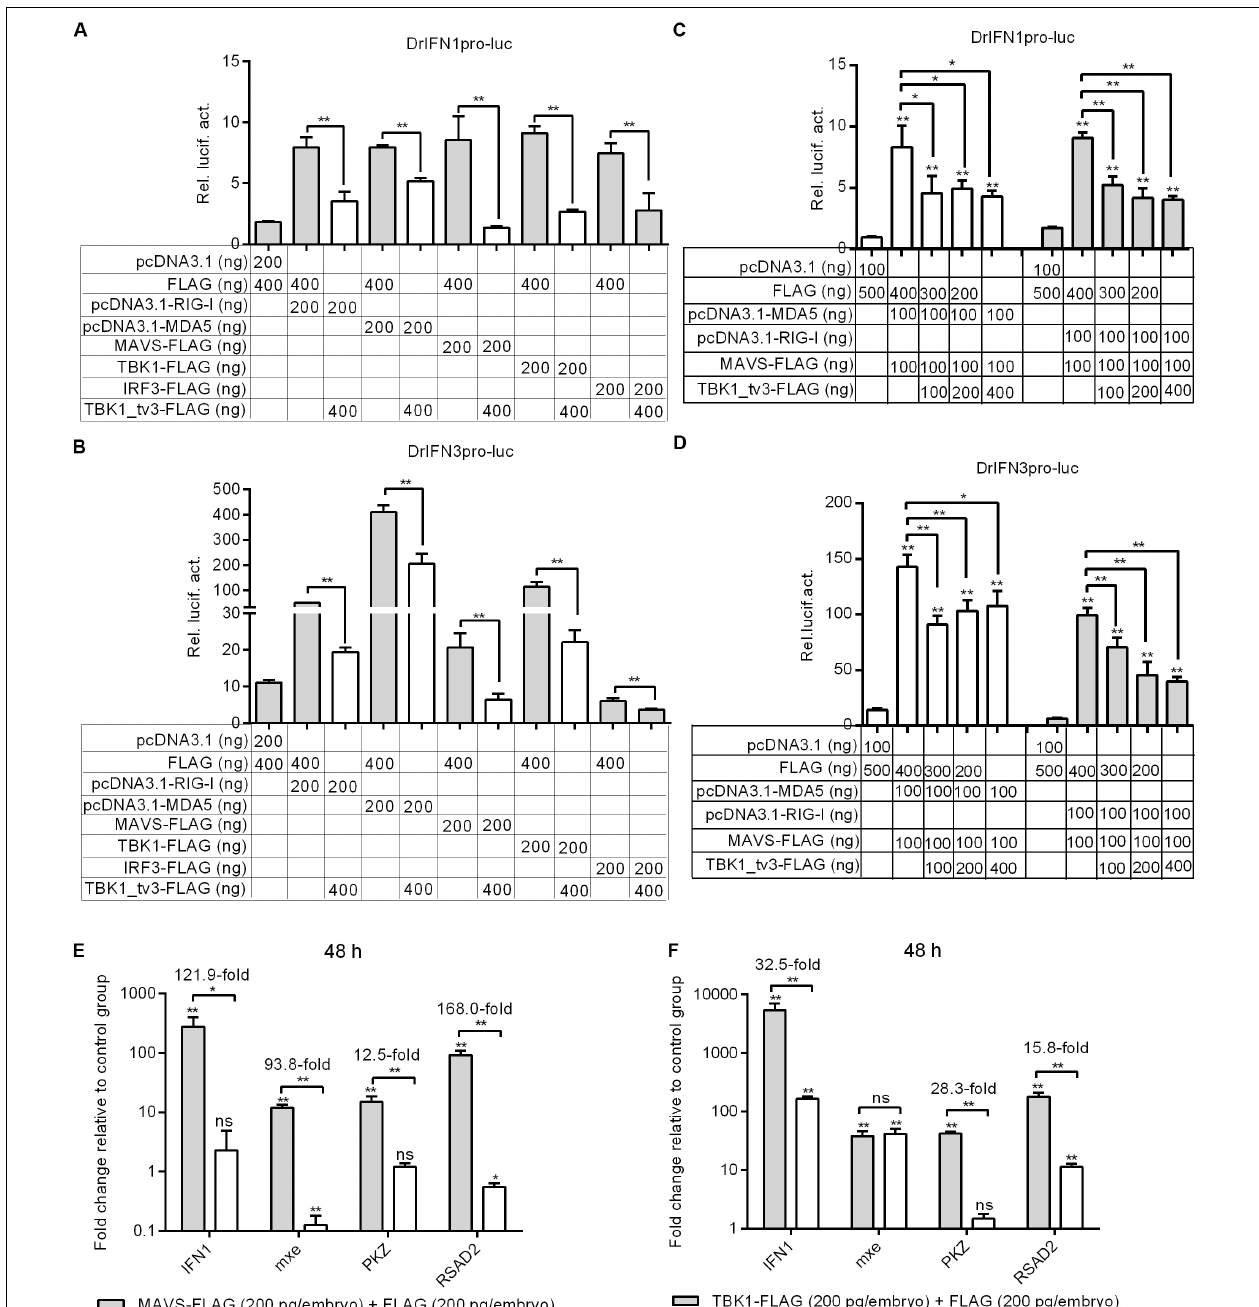
FIGURE 3 | TBK1_tv3 negatively regulates type I IFN mediated by RLR signaling pathway. (A) Effect of zebrafish TBK1_tv3 on the IFN1 promoter activity mediated by RLR signaling pathway. (B) Effect of zebrafish TBK1_tv3 on the IFN3 promoter activity mediated by RLR signaling pathway. (C) Effect of zebrafish TBK1_tv3 on the IFN1 promoter activity mediated by MDA5 or RIG-I and MAVS. (D) Effect of zebrafish TBK1_tv3 on the IFN3 promoter activity mediated by MDA5 or RIG-I and MAVS. For A–D , EPC cells seeded overnight in 24-well plates at 3 × 10 5 cells per well were transiently transfected with various indicated plasmids with indicated DNA concentration, together with 25 ng Renilla and 250 ng IFN1 or IFN3 reporter plasmids. After 48 h post-transfection, the cells were harvested for the detection of luciferase activity. (E) Effects of zebrafish TBK1_tv3 on expression of IFN and IFN-stimulated genes induced by MAVS. (F) Effects of zebrafish TBK1_tv3 on expression of IFN and IFN-stimulated genes induced by TBK1. For E,F , zebrafish embryos were microinjected at the one-cell stage with 100 ng of indicated expression construct. At 48 h post-fertilization, 50 embryos for each sample were used for RNA extraction. The p3xFLAG-injected group was used for control. Data represented means ± SEM ( n = 3) and were tested for statistical significance using one-way ANOVA followed by Tukey test. * p < 0.05; ** p < 0.01; and ns, not significant. The asterisk above the error bars indicated statistical significance using the group transfected with empty plasmid as the control group. The asterisk above the bracket indicated statistical significance between the two groups connected by the